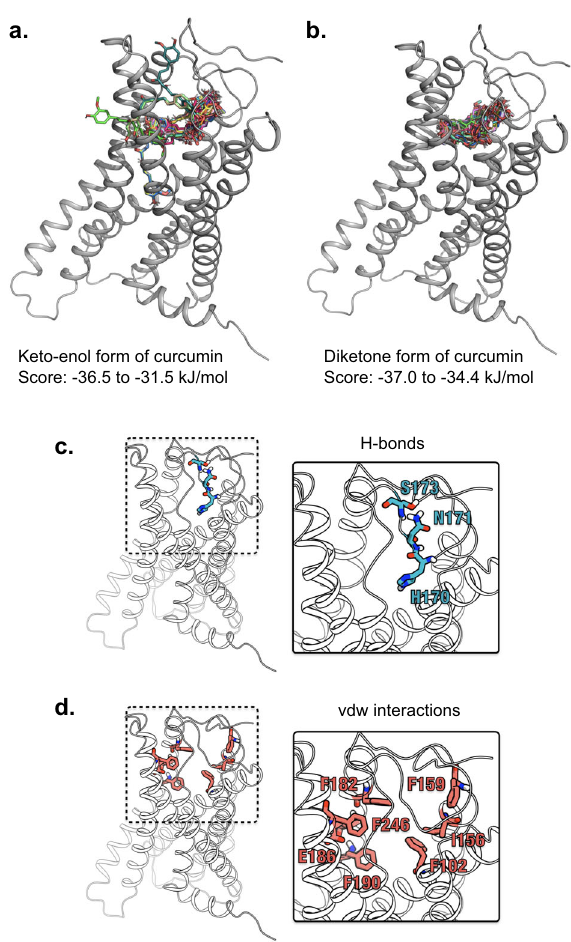
Fig. 5 Docking simulation of curcumin with GPR55. Molecular docking between curcumin and GPR55 was performed with AutoDock Vina. a , b After 100 docking simulations using the keto- enol and diketone forms of curcumin, respectively, the estimated binding forms and binding free energies values are shown. c , d Key amino acids for binding to curcumin are predicted with AutoMap analyses. Amino acid residues involved in hydrogen bonds ( c ) and van der Waals interactions ( d ) between GPR55 and curcumin are